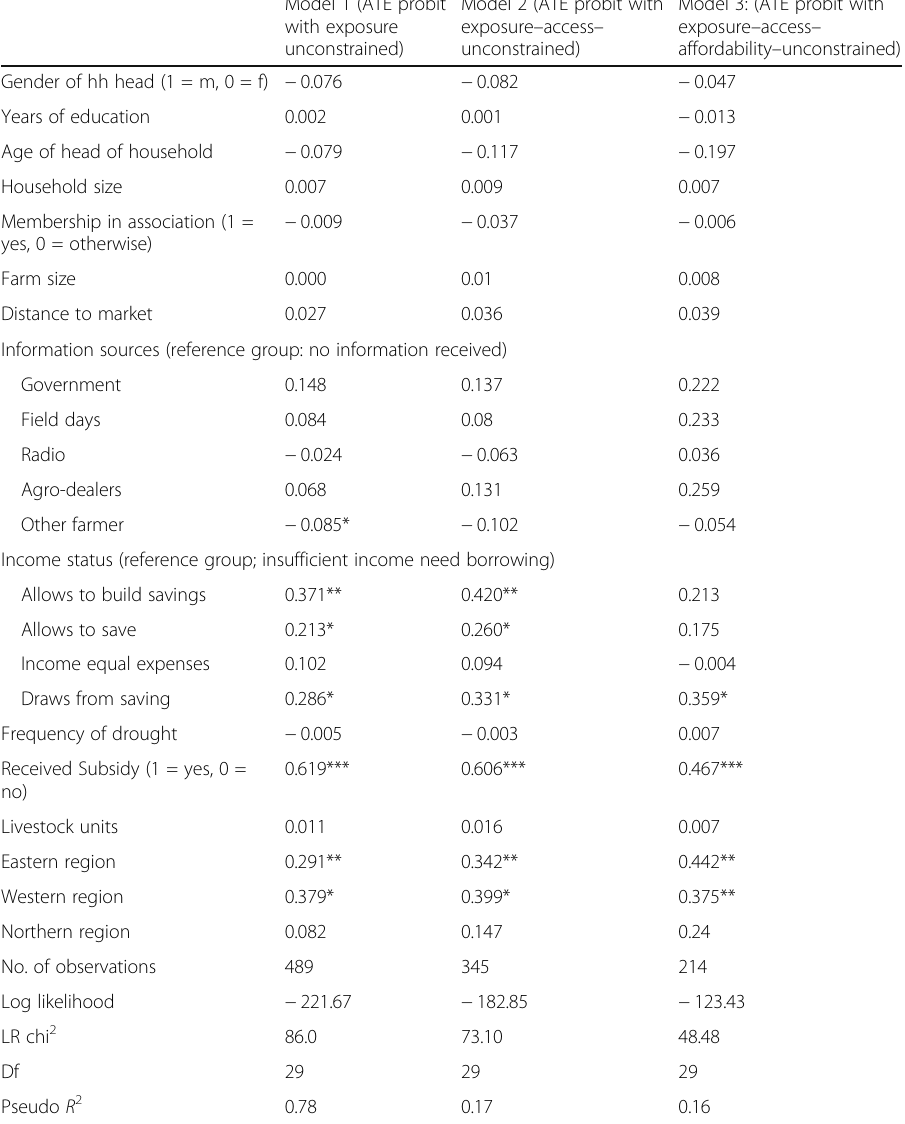
Table 5 ATE-corrected marginal effects of the determinants of adoption of DTMVs under heterogeneous seed access and information exposure